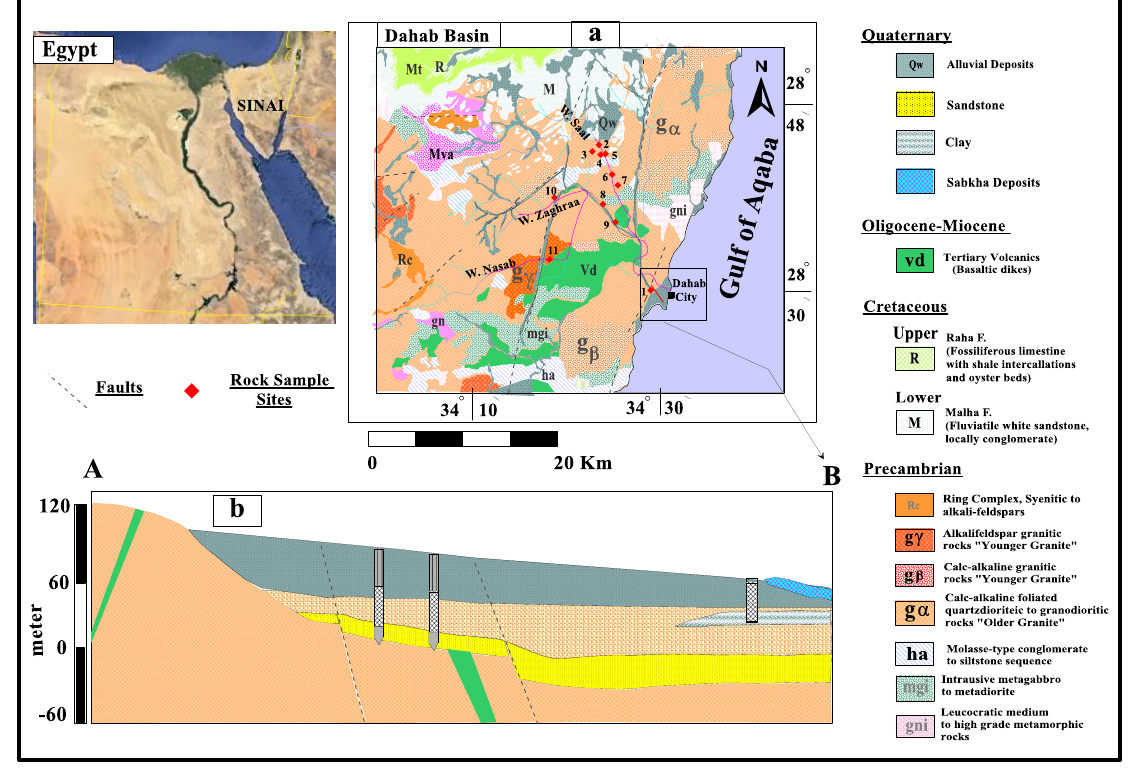
Figure 1. ( a ) Geological map of the Dahab watershed study area; ( b ) geological cross section